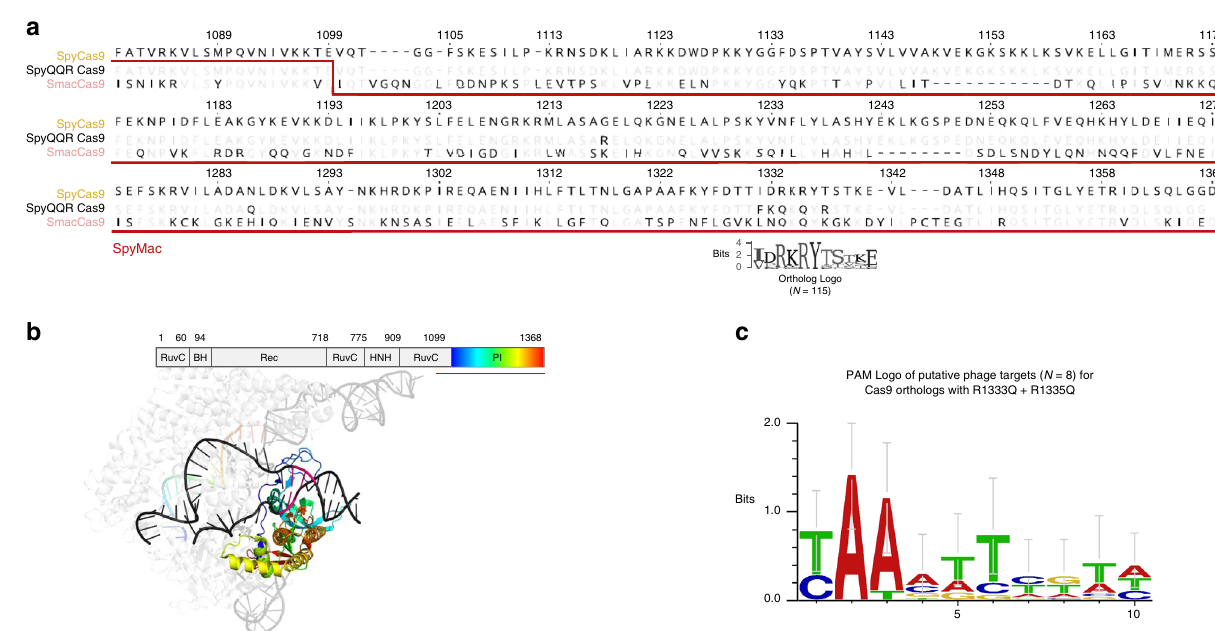
Fig. 1 Identi fi cation of features from natural PAM divergence through bioinformatics. a Sequence alignment of SpyCas9, its QQR variant, and SmacCas9. The step in the underlining red line marks the joining of SpyCas9 and SmacCas9 to construct a SpyMac hybrid. The sequence logo (Weblogo online tool) immediately below the alignment depicts the conservation at 11 positions around the PAM-contacting arginines of SpyCas9. b The domain organization of SpyCas9 juxtaposed over a color-coded structure of RNA-guided, target-bound SpyCas9 (PDB ID 5F9R). The two DNA strands are black with the exception of a magenta segment corresponding to the PAM. A blue – green – red color map is used for labeling the Cas9 PI domain and guide spacer sequence to highlight structures that confer sequence speci fi city and the prevalence of intra-domain contacts within the PI 43 . c A sequence logo generated online (WebLogo) that was input with putative PAM sequences found in Streptococcus phage and associated with close SmacCas9 homologs.